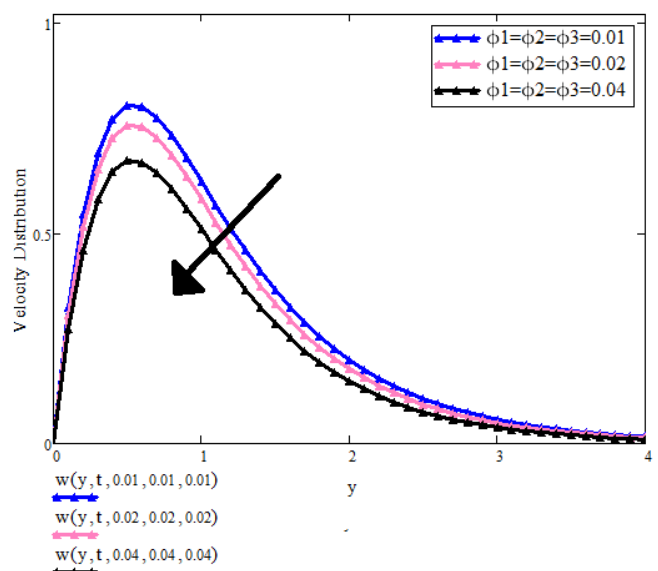
Figure 6. u ( y , t ) with φ 1 , φ 2 , φ 3 when t = 1, a = 0.01, λ = 0.5, λ 2 = 0.9, Pr = 6.2, β 1 = 0.9, φ 1 = φ 2 = φ 3 = 0.02.